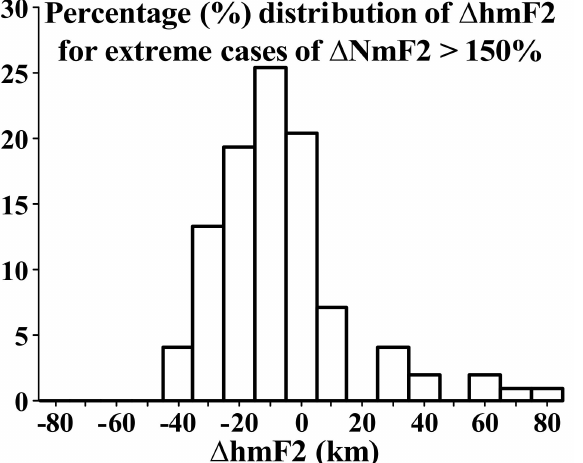
Figure 6. Histogram of the percentage distribution of ∆ hmF2 for extreme cases of ∆ NmF2 >